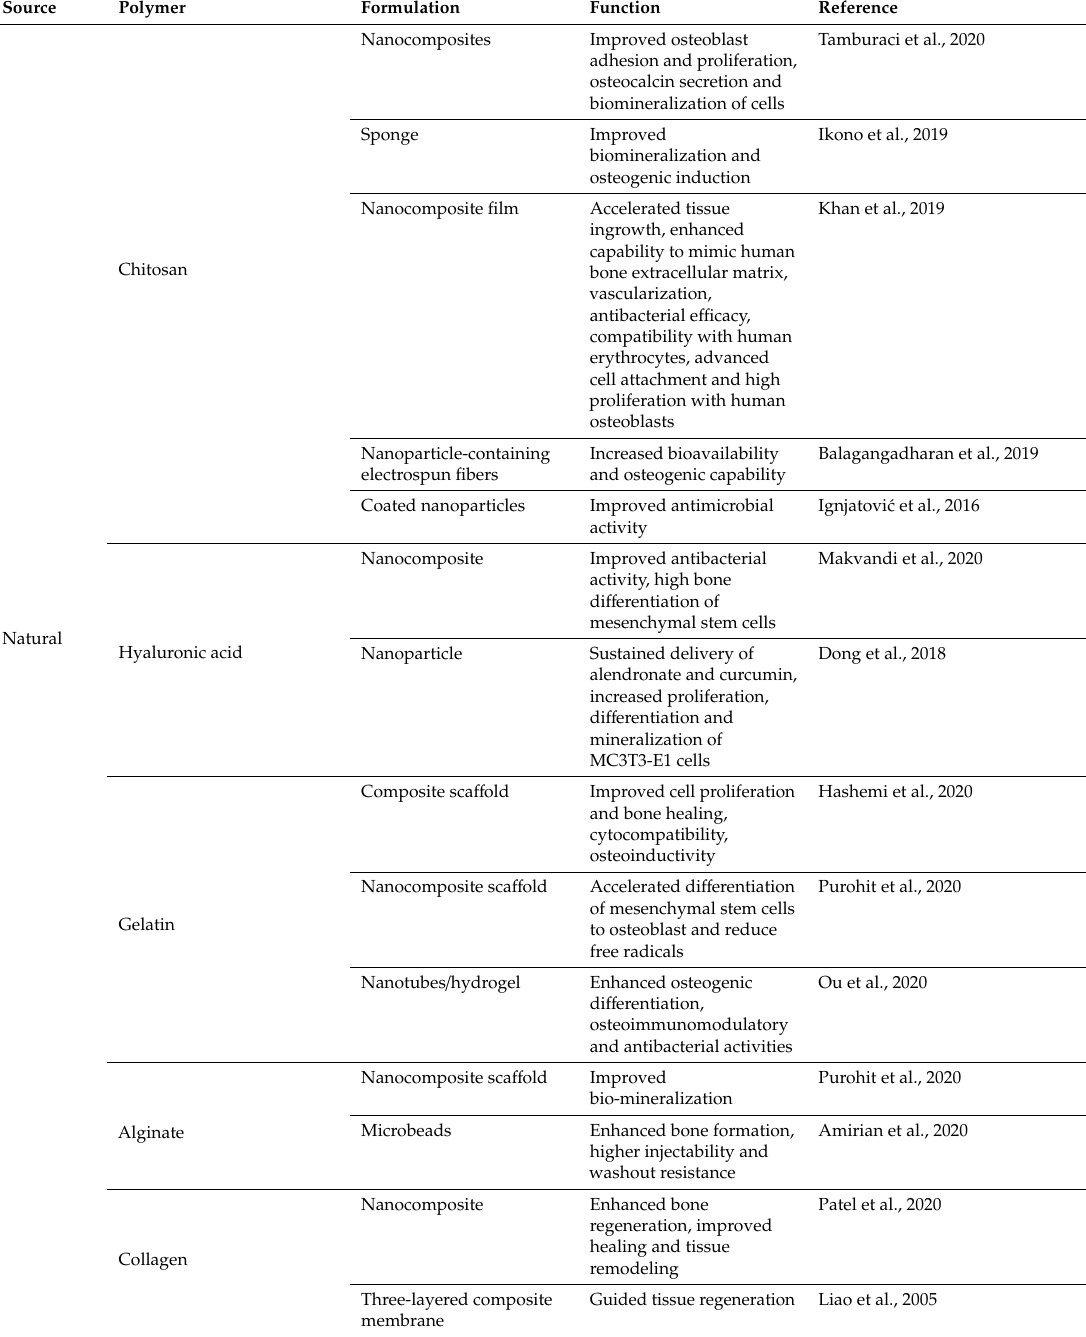
Table 2. A summary of the most recent and relevant publications on nano- and micro-particle polymer formulations for bone